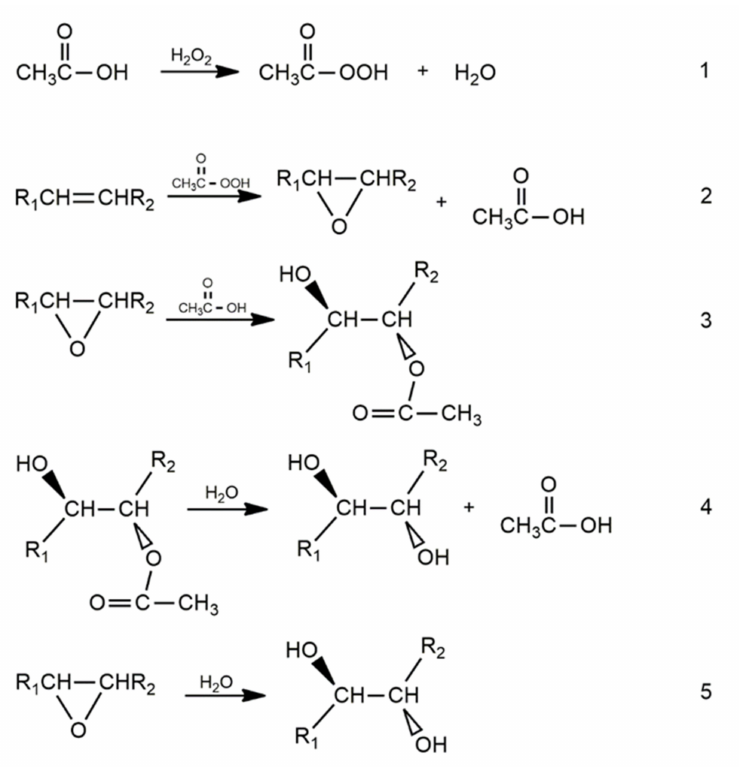
Figure 3. Reactions taking place in the process of synthesis of primary polyols (epoxidation with carboxylic acid, water